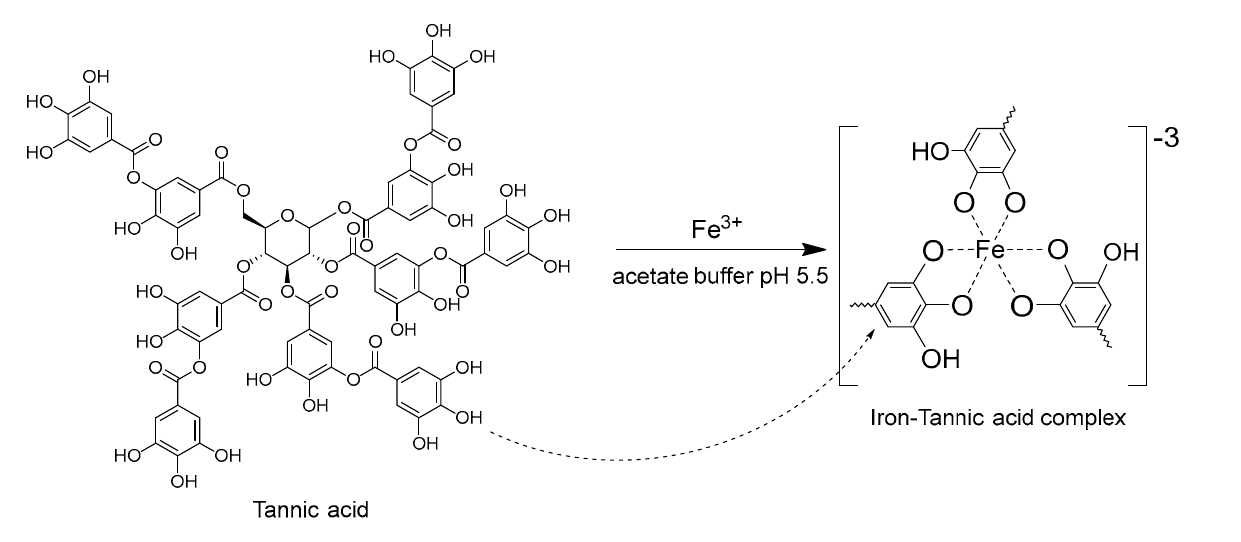
Figure 3. Complex formation between tannin and iron(III) [47,48].